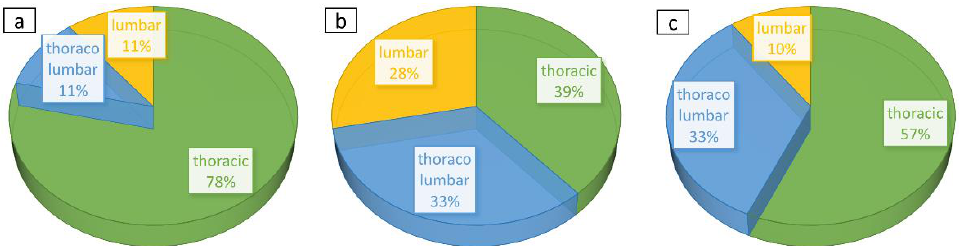
Figure 7. Diagrams illustrating percentage distribution due to topography of scoliosis in the study cohort. ( a ) — deterioration group, ( b ) — improvement group, ( c ) — unchanged group.